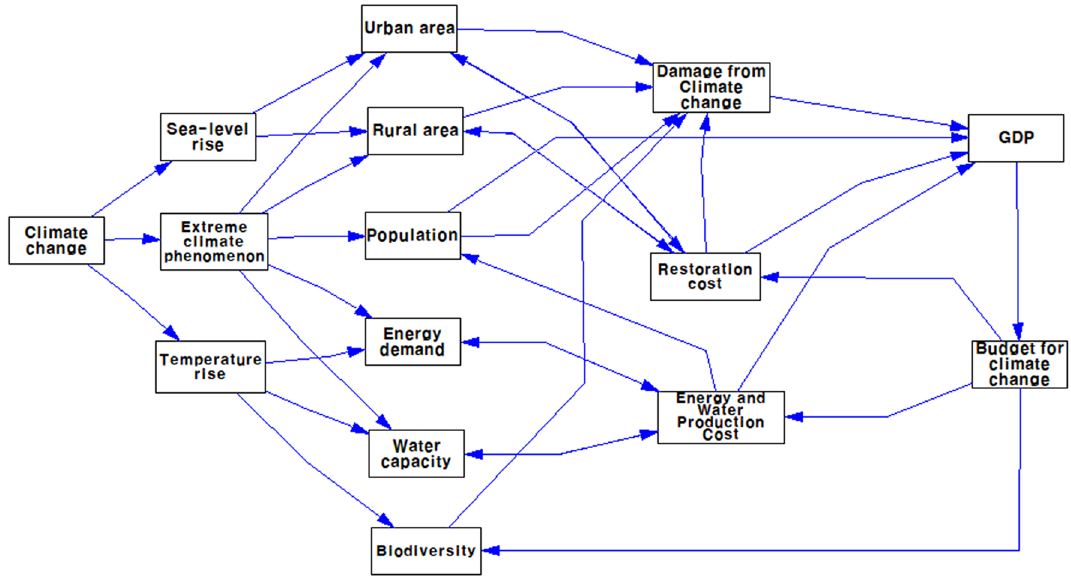
Figure 2. Structure of the climate change impact model. GDP = Gross Domestic